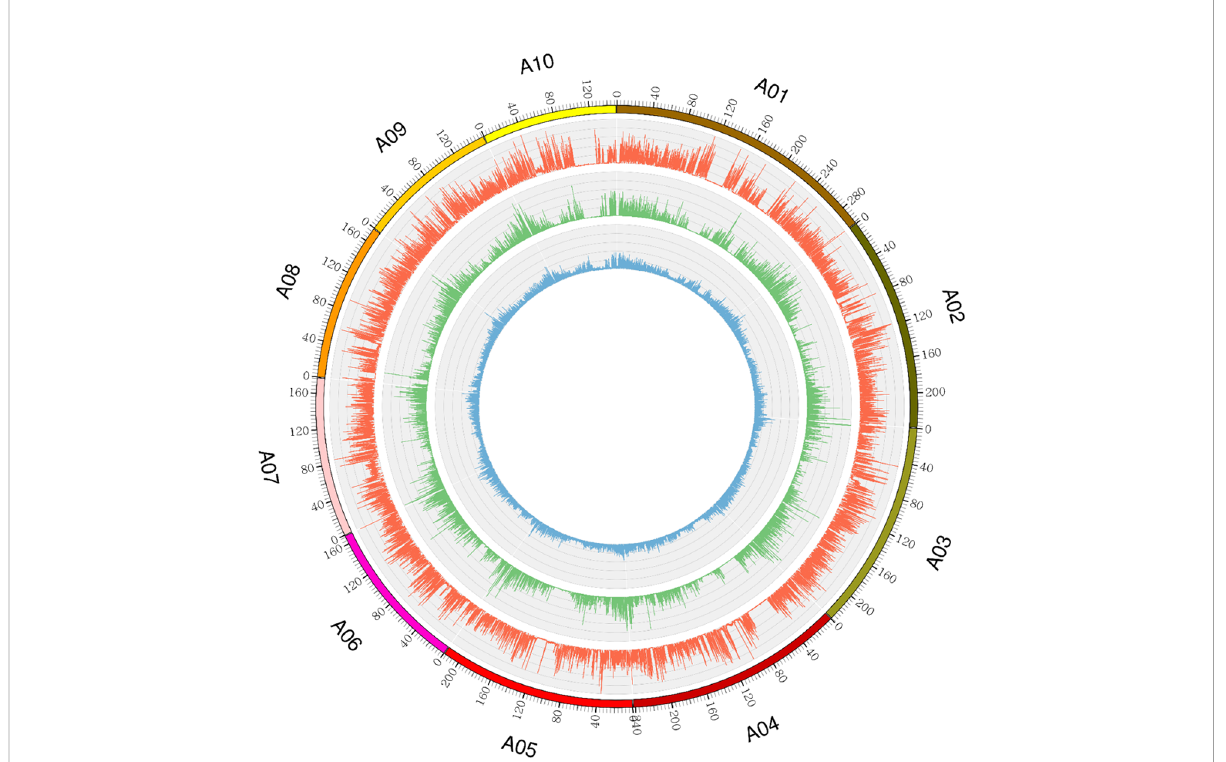
FIGURE 2 Genome-wide distribution of SNPs and genetic variants in the Ji846 and Ye3189 genomes. The outermost circle with scale represents the ten chromosomes. The orange histogram represents the density of SNPs that are polymorphic between Ji846 and Ye3189; the green histogram represents the density of polymorphic SNPs within the coding sequences of Ji846 and Ye3189; the blue histogram indicates the density of insertions and deletions (Indels) between Ji846 and Ye3189.